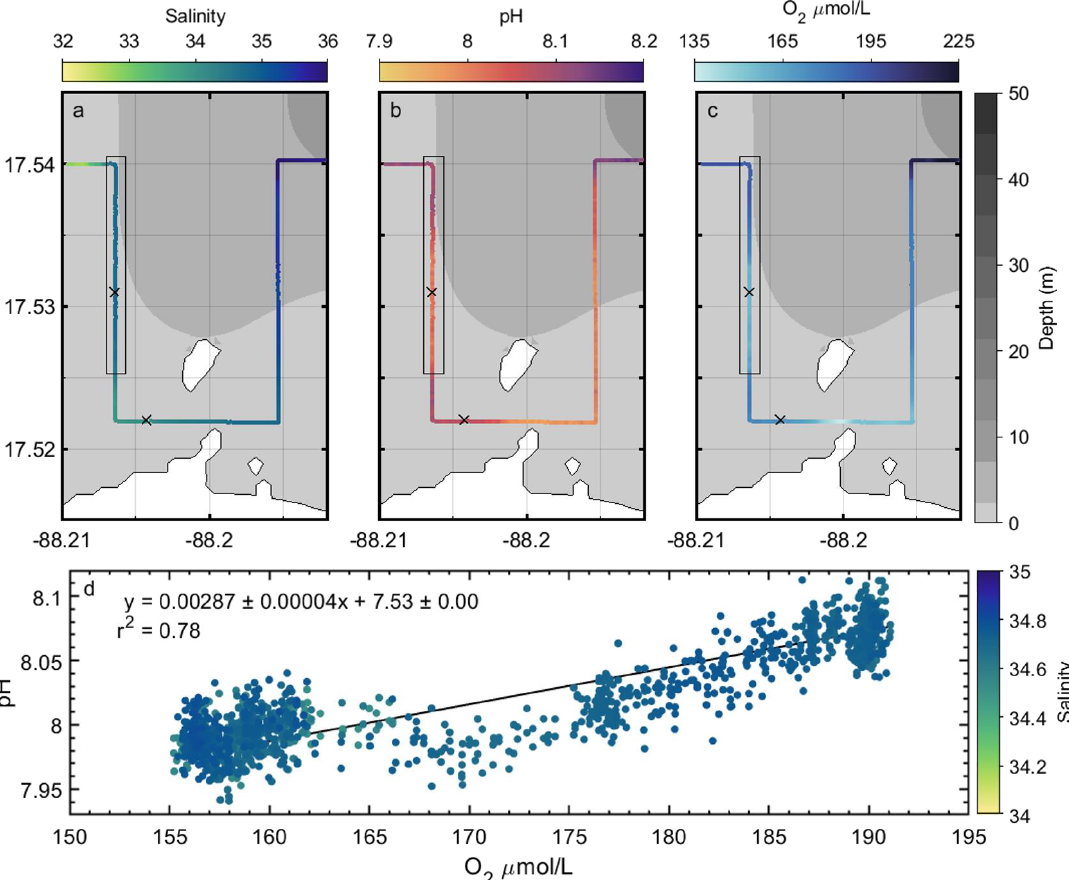
Figure 9. High-resolution sensor data capture small-scale spatial variability in three different parameters in a zoomed in section from Transect 1. ( a ) Salinity ( b ) pH, and ( c ) Dissolved Oxygen. Discrete water sample locations are marked on with an X, rectangle shows 1.6 km stretch where we see changes in pH and O 2 but not salinity. ( d ) Correlation between O 2 , pH, and salinity from within black box in the top panels.